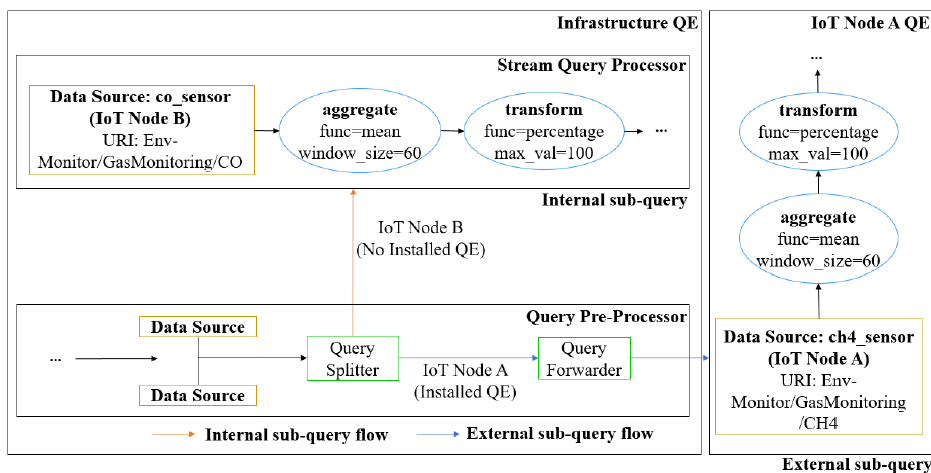
Figure 10. Query splitting demonstration.